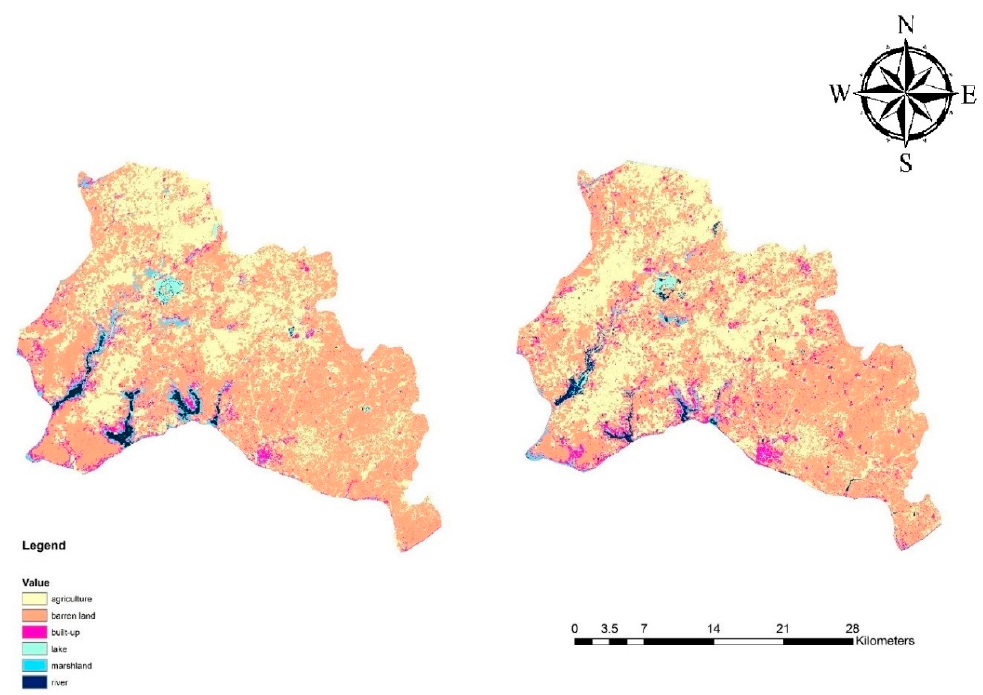
Figure 7. Land use/land cover map of the study area for the year 2001 and 2011.